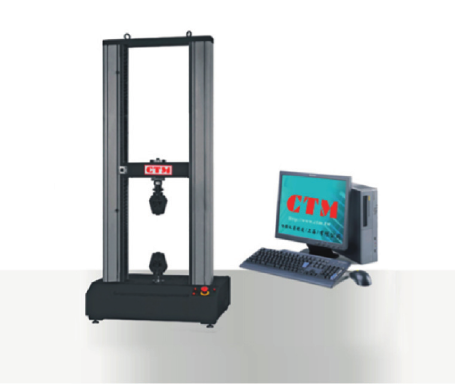
Figure 1: Tensile test device